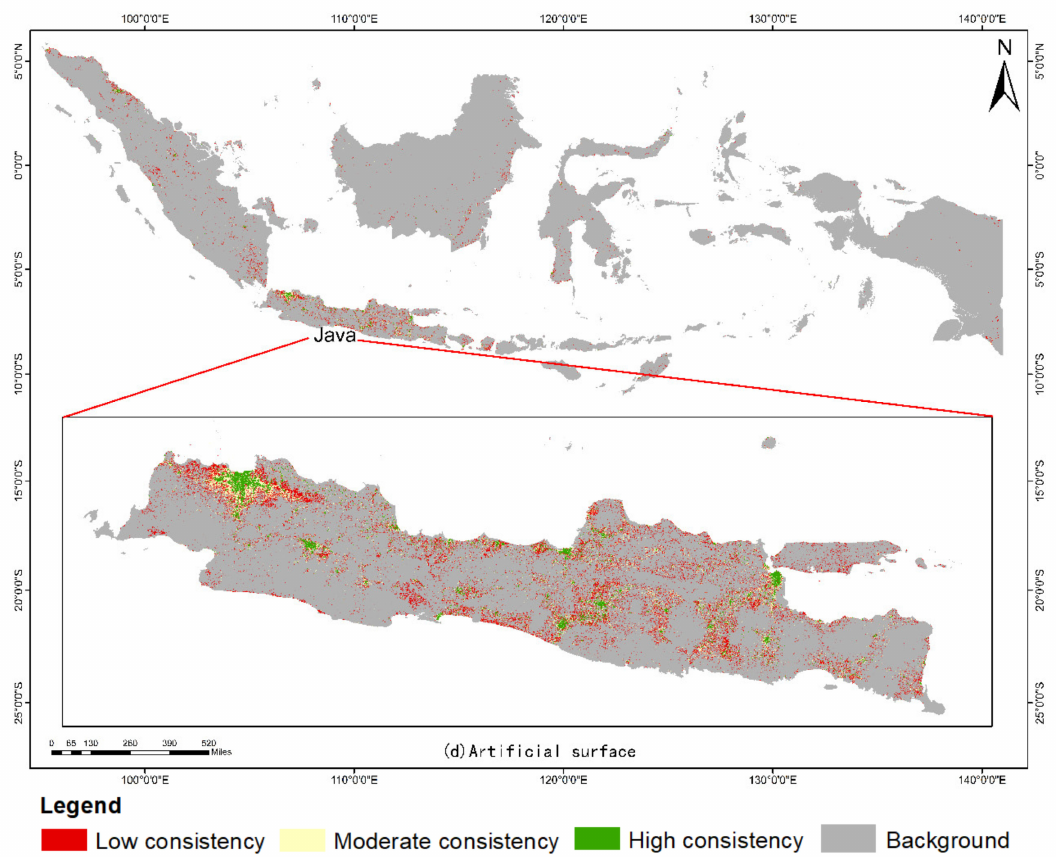
Figure 6. Spatial consistency distributions of major land cover types in the study area: ( a ) cropland, ( b ) forest, ( c ) grassland, and ( d ) artificial surface.